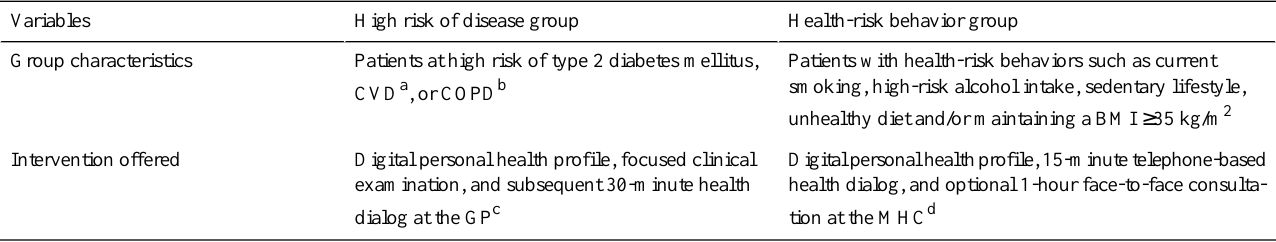
Table 1. Group characteristics and preventive activities offered to participants in the high-risk of disease group and the health-risk behavior group (groups 2 and